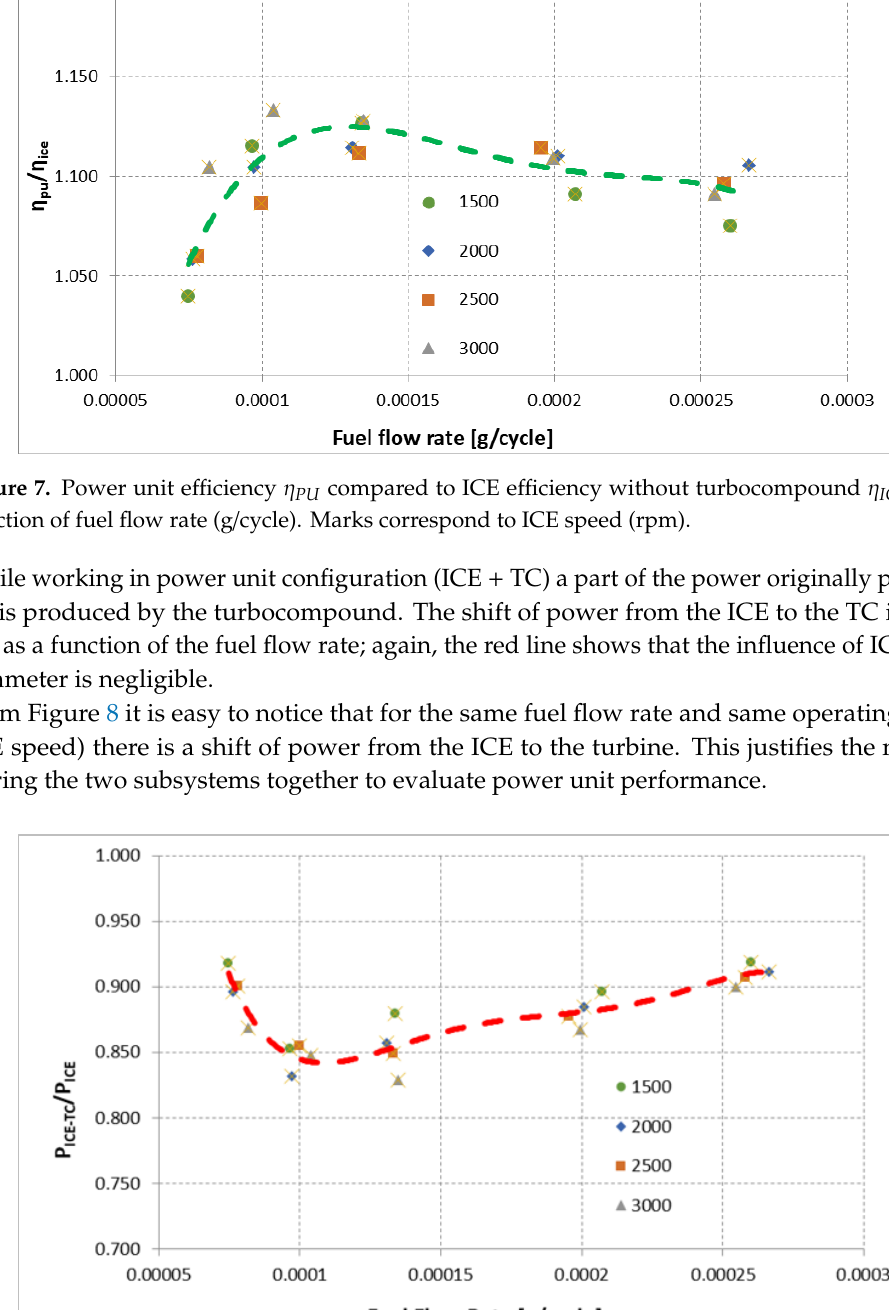
Figure 8 Ratio between ICE power with turbocompound ( _TC ICE P ) and ICE power without Figure turbocompound ( ICE P ), as a function of fuel flow rate (g/cycle). Marks correspond to ICE speed (rpm).